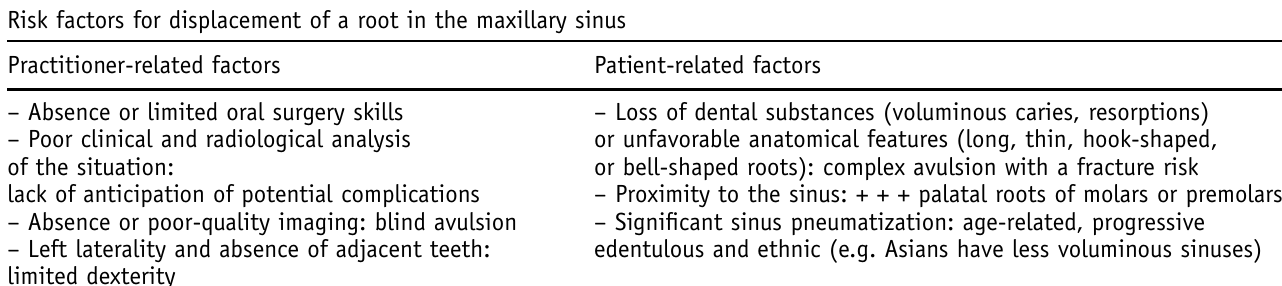
Table III. Distribution of risk factors for the displacement of a root in the maxillary sinus to assess whether there is any risk. Risk factors for displacement of a root in the maxillary sinus Practitioner-related